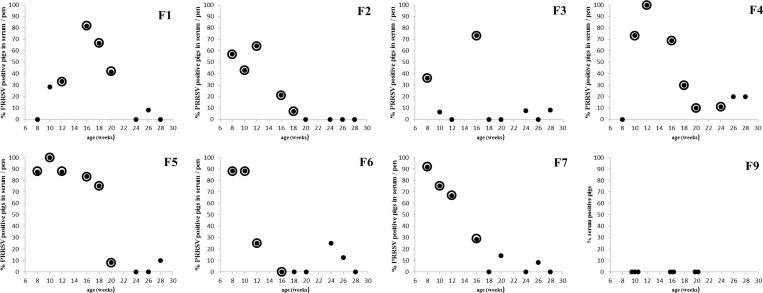
Overview of PRRSV detection by qRT-PCR in serum and oral fluid collected on seven endemically PRRSV infected farms (F1-F7) and one PRRSV free farm (F9).Full dots indicate the percentage of PRRSV positive pigs in serum per pen. If the full dot is surrounded by an open circle, it indicates that the corresponding pen based oral fluid sample was positive in qRT-PCR.